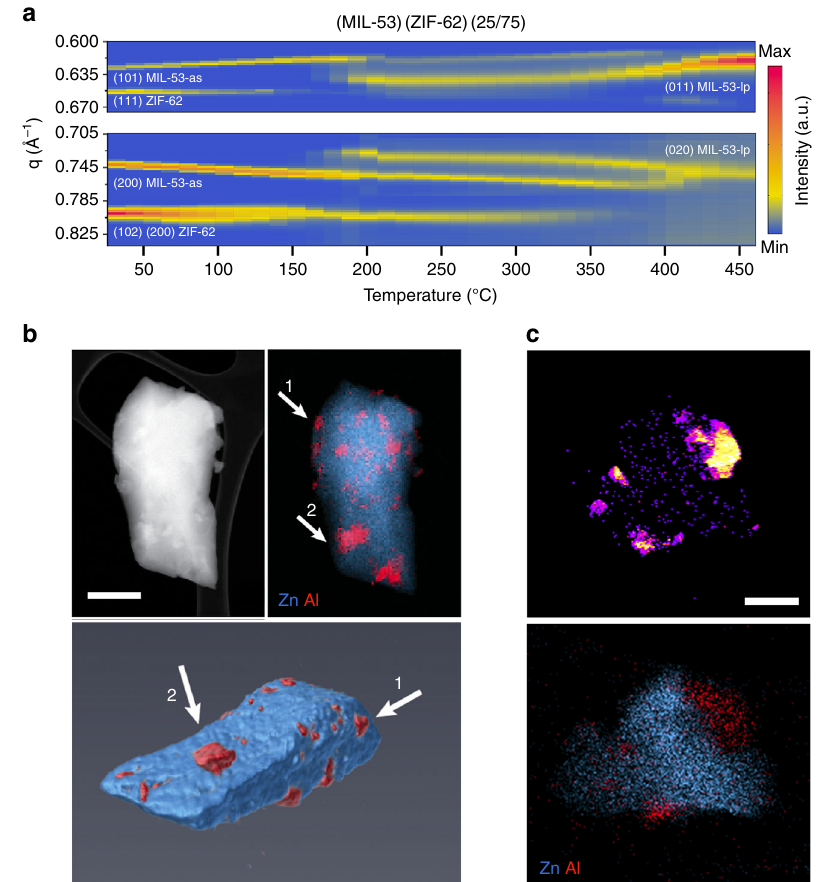
Fig. 2 Distribution of crystalline/amorphous phases with the (MIL-53) 0.25 (a g ZIF-62) 0.75 CGC. a Contour plots of in situ synchrotron powder diffraction data measured during the thermal treatment process of (MIL-53)(ZIF-62)(25/75) (10 °C min − 1 ). The Bragg peak hkl indices are marked for ZIF-62, MIL- 53-as and MIL-53-lp. b Three-dimensional tomography and the corresponding STEM-EDS mapping of (MIL-53) 0.25 ( a g ZIF-62) 0.75 CGC. White arrows highlight the region of Al in both 2D and their corresponding 3D images. Scale bar is 400 nm. c Scanning electron diffraction (SED) mapping and the corresponding STEM-EDS mapping of the composite glass. Scale bar is 200 Peaks from both phases remain until 420 °C, when only Bragg peaks arising from MIL-53-lp are observed. We ascribe this broad transition to the constant heating rate used and the need to perform the experiment in a sealed capillary under Ar.